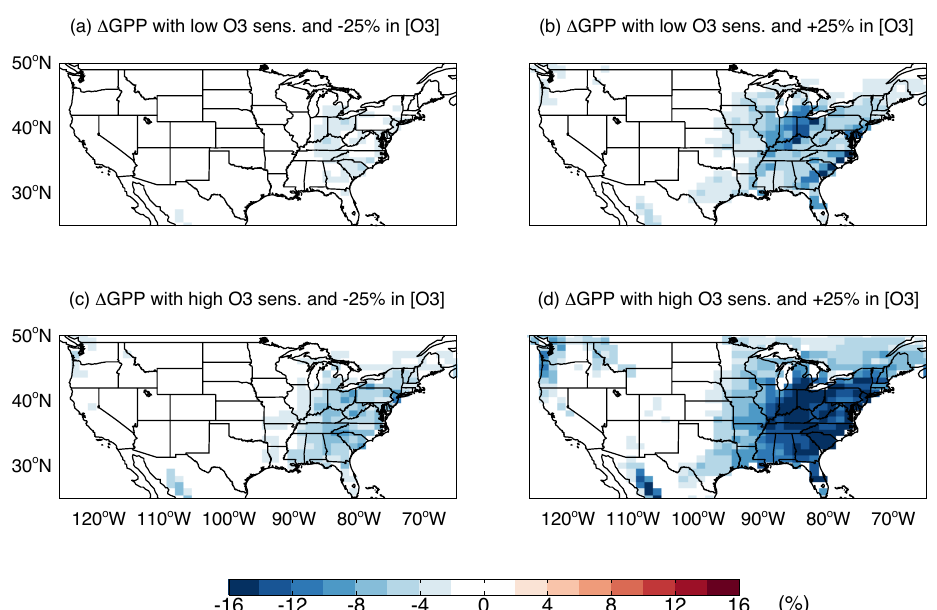
Figure 9. Simulated changes in summer GPP due to (a, c) 25% reduction or (b, d) 25% increase in [O 3 ] for (a, b) low or (c, d) high O 3